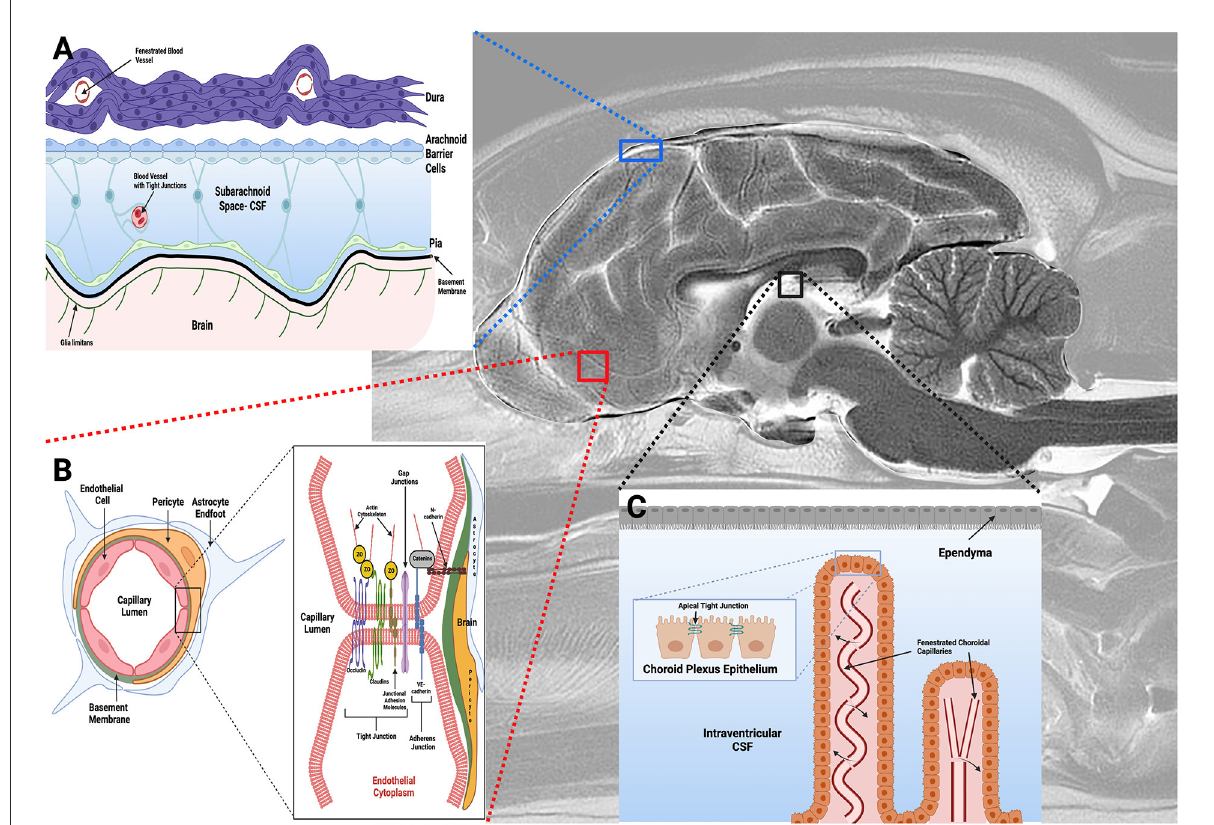
FIGURE1 Barriers of the central nervous system. (A) The arachnoid barrier consists of arachnoid epithelial cells with tight junctions between adjacent cells, and forms a barrier between cerebrospinal fluid (CSF) in the subarachnoid space (SAS) and the more superficial dura mater. Blood vessels in the SAS have tight junctions with similar barrier characteristics as BECs in the BBB, while blood vessels within the dura are fenestrated. (B) The blood-brain barrier (BBB) exists at the level of the BECs, and is composed of a structural unit that also includes pericytes, astrocytic endfeet, and the basement membrane. Junctional complexes, including tight and adherens junctions ( B , inset), between endothelial cells restrict paracellular movement of substances across the BBB. (C) The blood-CSF barrier is found in the choroid plexuses within the ventricular system of the brain, with apical tight junctions ( C , inset) between choroid plexus epithelial (CPE) cells. The CPE contains apical microvilli, which increase the surface area of exchange between the CPE epithelial and CSF. Choroidal capillaries are fenestrated and do not form a barrier (arrows). Figure created with